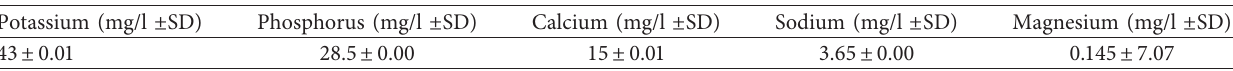
Table 4: Mineral composition values of crude powder of Senna occidentalis roots.